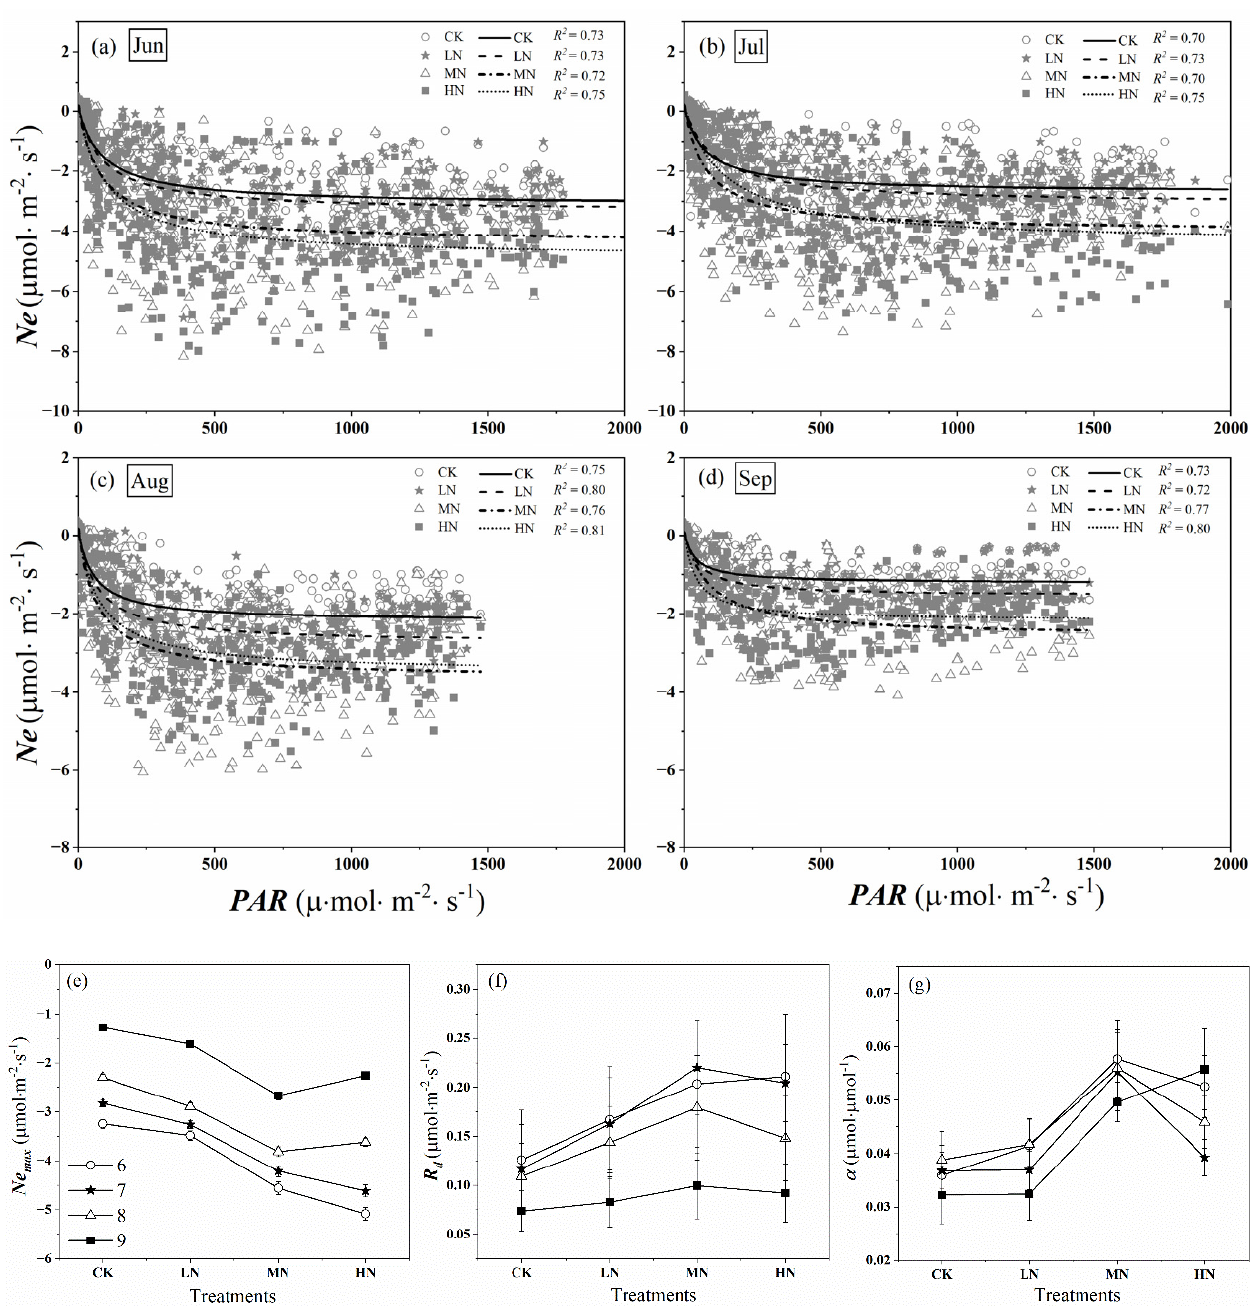
Figure 8. Ne − PAR relations from June to September ( a – d ). Dots represent hourly daytime Ne values; curves are Michaelis– Menten equation fits (Equation (4)). The solid lines, dashed lines, dot-dash lines, and dotted lines show the Ne − PAR curves under CK (control, no nitrogen addition), LN (low nitrogen addition, 23 kgN · hm − 2 · a − 1 ), MN (medium nitrogen addition, 46 kgN · hm − 2 · a − 1 ), and HN (high nitrogen addition, 69 kgN · hm − 2 · a − 1 ) treatments, respectively. Equation fitting parameters for these months are presented in ( e – g ): maximum net photosynthetic rate of crown ( Ne max ), the daytime respiration of crown ( R d ), and initial quantum efficiency ( α ).